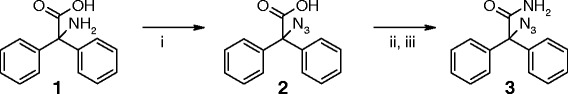
The synthesis of azidodiphenylacetamide 3. (i) Triflyl azide, K2CO3, Cu(II)SO4·5H2O, CH2Cl2, CH3OH, 16 hr, room temperature (RT), 75% yield. (ii) SOCl2, CH3CN, 90 min, reflux. (iii) NH4, CH3CN, 16 hr, RT, 76% yield.